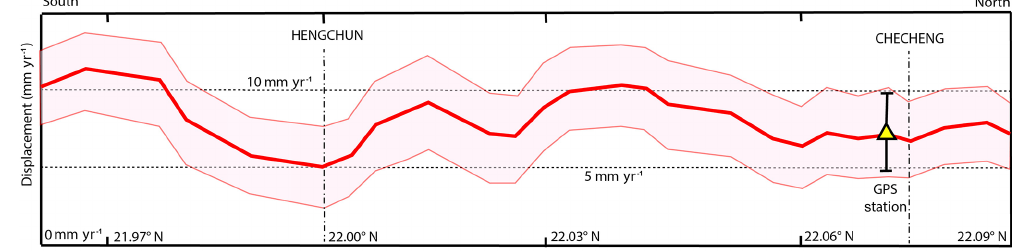
Figure 12. Hengchun Fault along-strike variation of LOS velocity offset (perpendicular to the fault, in mmyr − 1 ) including Hengchun and Checheng. Note the active interseismic displacement and its along-strike variations which confirms that Hengchun Fault is an active interseismic creeping fault of Taiwan. Furthermore the LOS velocities’ variations are important in terms of seismic hazards as they reveal the location of slowly creeping areas where stress may accumulate at depth, such as those areas close to both Checheng and Hengchun and higher active tectonic areas such as in between Checheng and Hengchun or south of Hengchun Valley. Part of the deformation may also be distributed in the eastern part of the Hengchun Fault (e.g., the Kenting Fault and/or within the intrusion of the Kenting Mélange in between both Hengchun and Kenting faults; see Fig. 14).